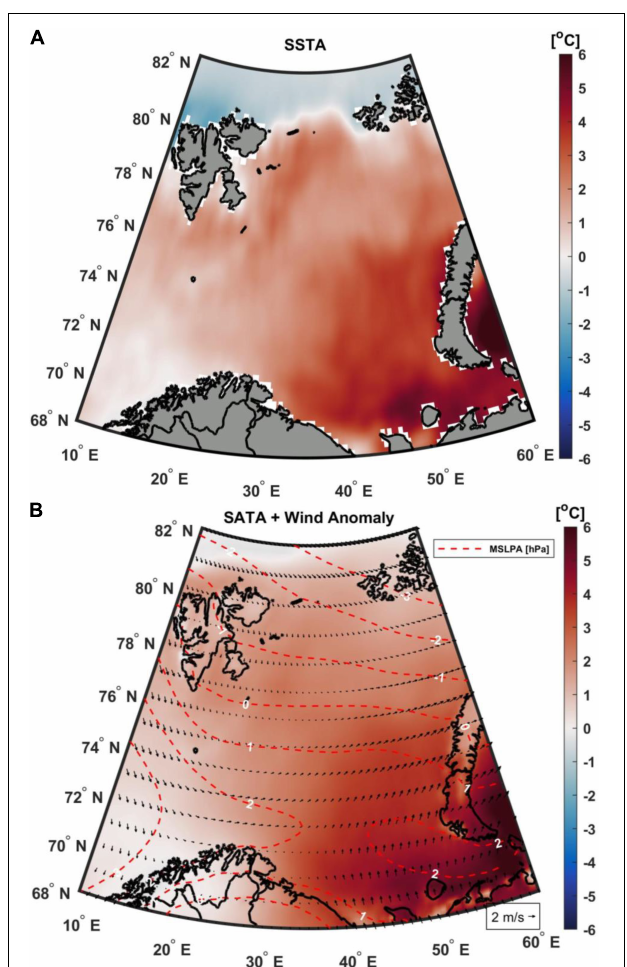
FIGURE 9 | (A) Spatial distribution of mean SST anomaly (SSTA) in the Barents Sea during the most intense (“strong”) MHW event (28 June to 29 August 2016), (B) Corresponding anomalies in 2 m air temperature (SATA, shaded), mean sea level pressure (MSLPA, dashed contours red line, units: hPa), and wind velocity anomalies (black arrows denote magnitude and direction of wind anomaly, scale arrow at bottom right, units: